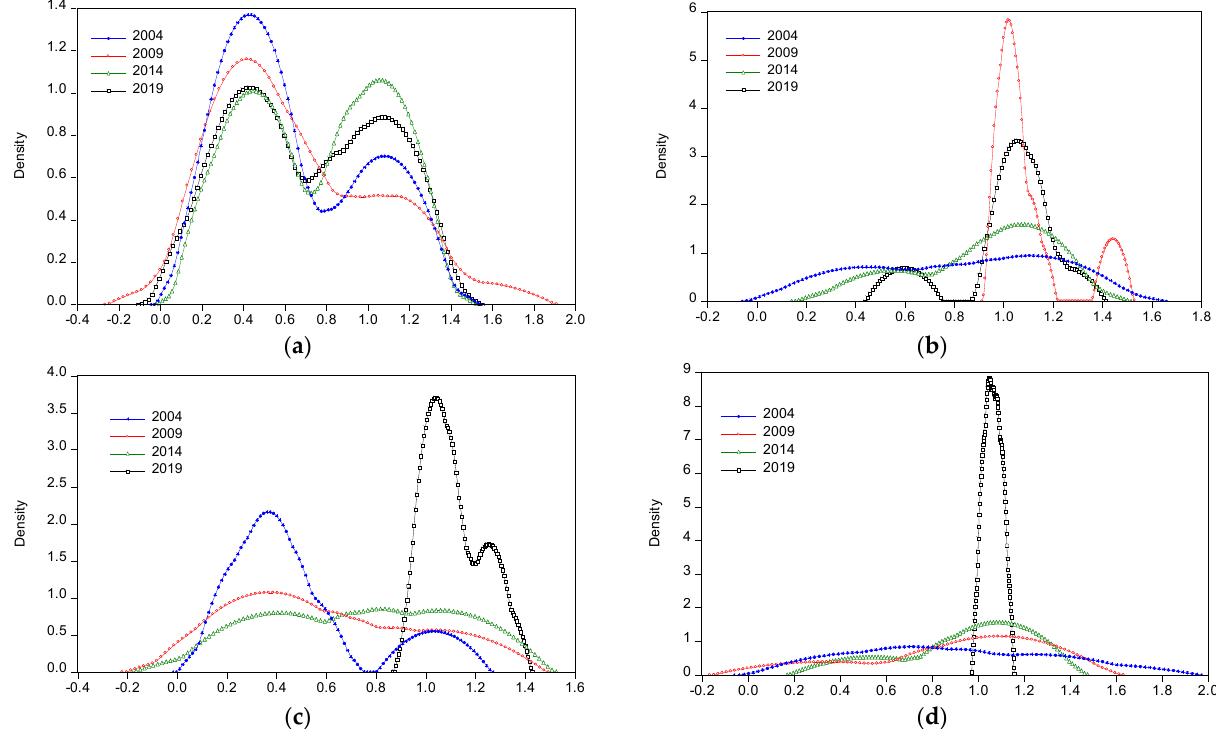
Figure 6. Evolution of GLUE of resource-based cities in each type of the YRB. ( a ) Mature cities; ( b ) Growing cities; ( c ) Recessionary cities; ( d ) Regenerative cities.